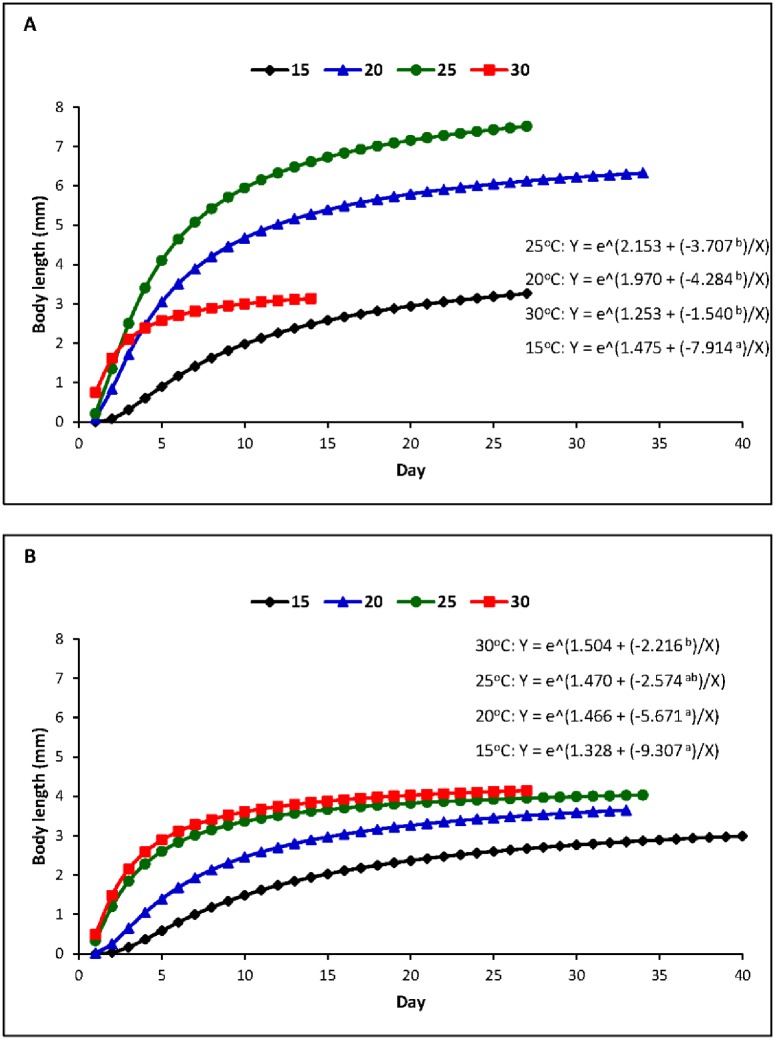
Growth curves of body length at different temperatures.A, B. kugenumaensis. B, E. braueriana. Different superscript letters (a, b) indicated the significant pairwise groups of different temperatures by post hoc analysis.